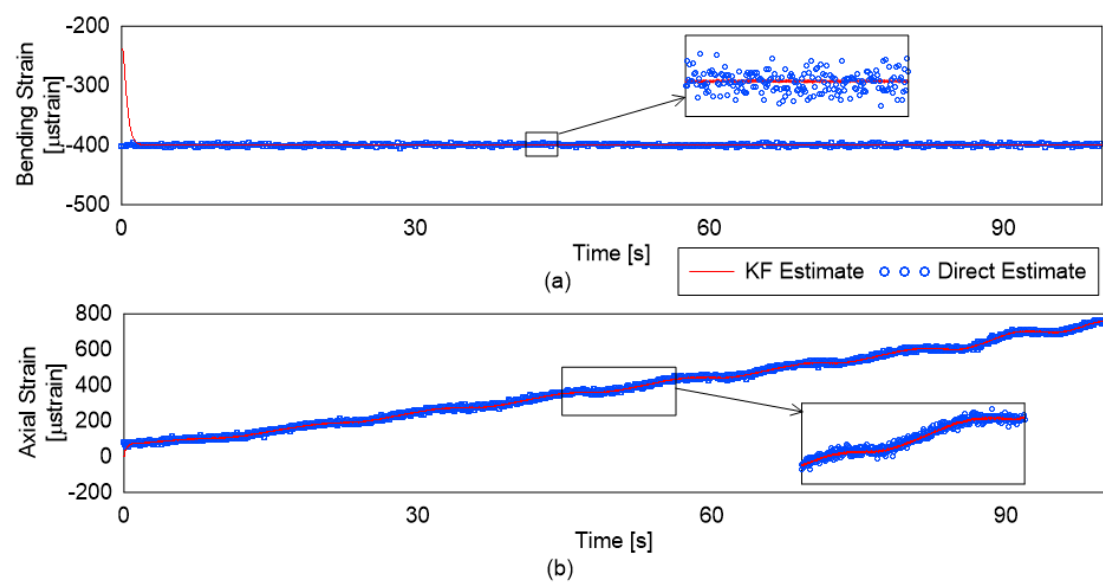
Figure 10. Load estimations under loading